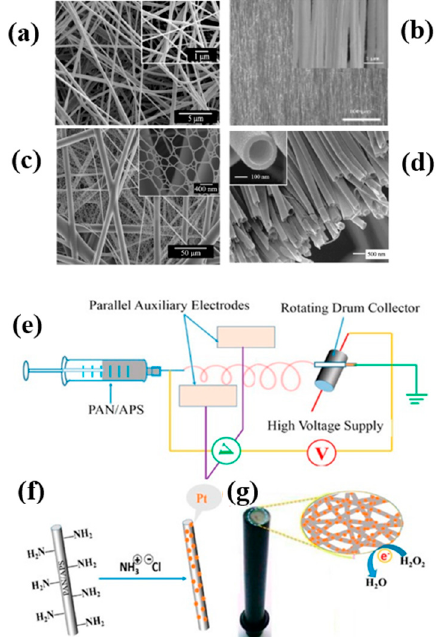
Figure 1. ( a ) SEM image of irregular fibers, [26] copyright 2010 Elsevier; ( b ) SEM image of highly oriented fibers, [27] copyright 2007 Scitation; ( c ) SEM image of nano-nets, [28] copyright 2011 Royal Society of Chemistry; ( d ) SEM image of hollow fiber, [29] copyright 2004 American Chemical Society; ( e ) model of a home-made electrospinning instrument for the synthesis of polyacrylonitrile/3- aminopropyltriethoxysilane (PAN/APS) hybrid nanofibers; ( f ) electrostatic assembly mechanism of platinum NPs (PtNPs) along amino-modified PAN nanofibers; ( g ) PAN–PtNPs hybrid nanofibrous